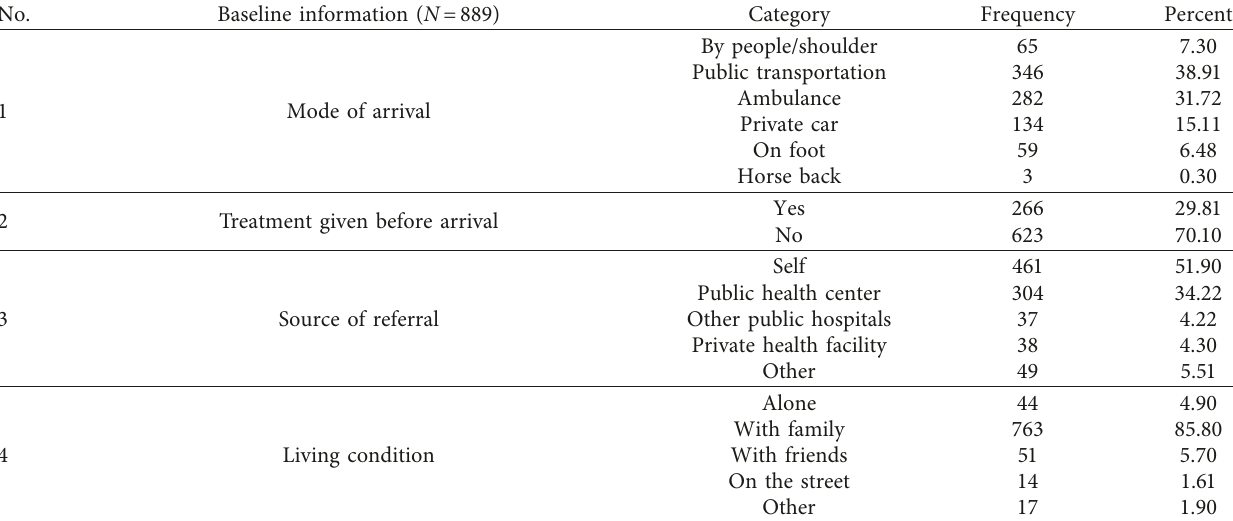
Table 2: Distribution of emergency patients by their baseline information, Nekemte, Ethiopia, 2017.